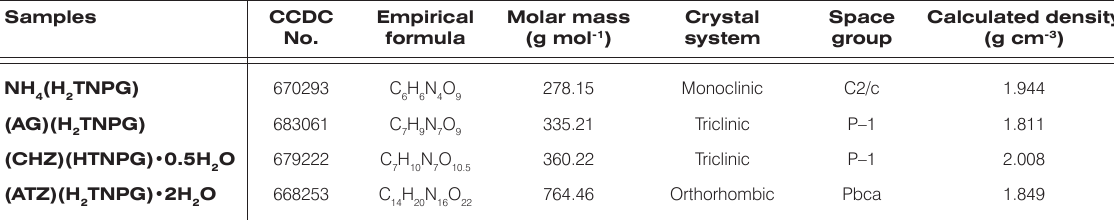
(H TNPG), (AG)(H 4 2